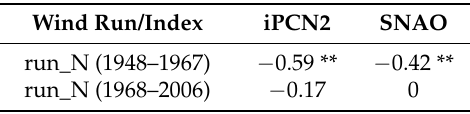
Table 4. Linear correlations (monthly data).